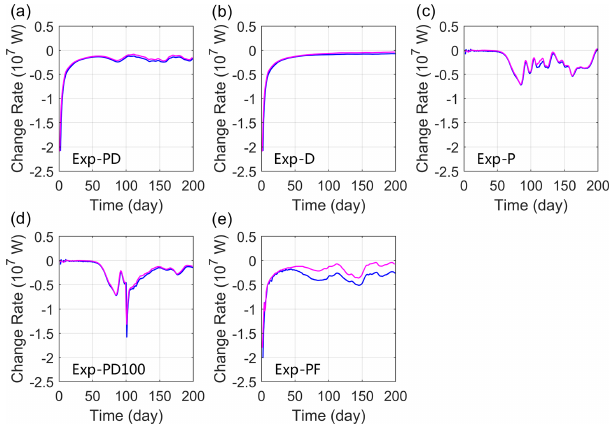
Figure 12. The change rate of APE (magenta curve) and g(ρ − ρ r )w (blue curve) integrated over the model domain as func- tions of time from the base and sensitivity experiments.